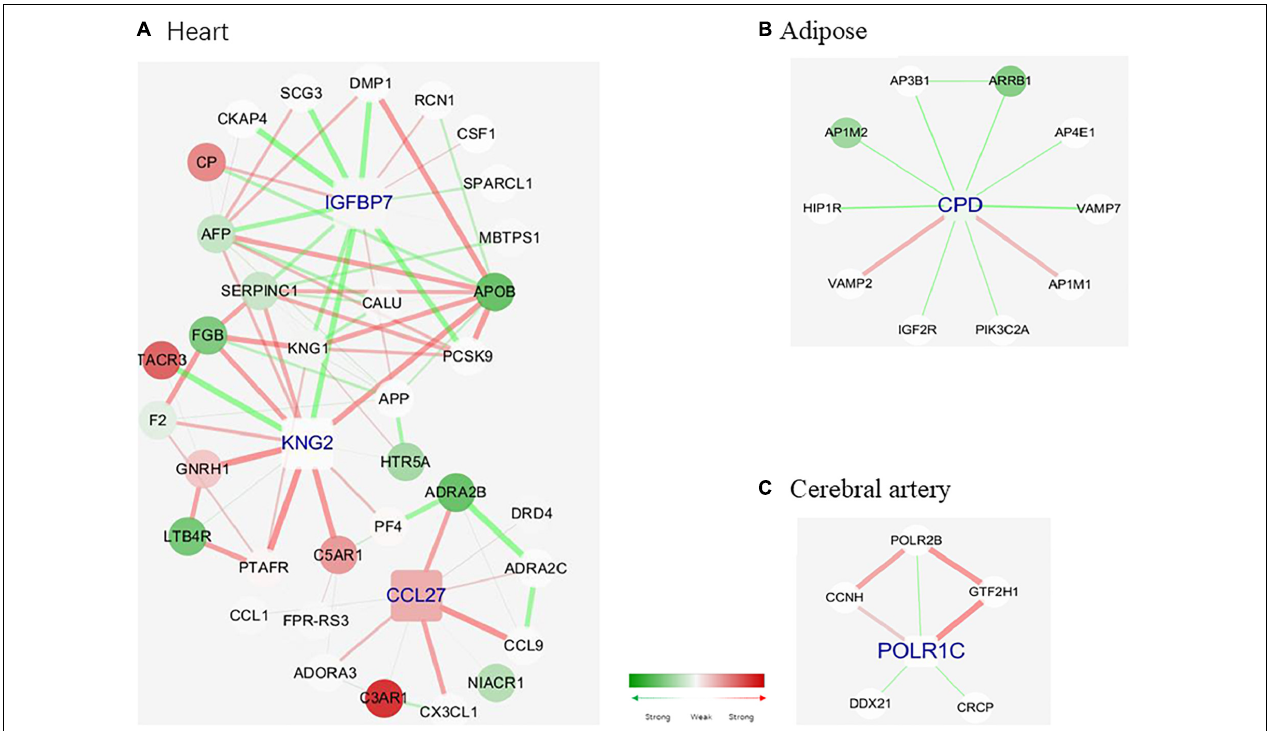
FIGURE 6 | Tissue-specific hub genes and their corresponding modules. (A) IGFBP 7, KNG 2, and CCL 27. (B) CPD. (C) POLR1C. Gene colored in green means differential expression between disease and health conditions and was significantly downregulated under disease, while red means upregulated. One edge colored with green means the interaction between its two linked genes was perturbed and was inactivated under disease condition, while red means activated. The width of edges reflects the magnitude of the perturbation. Tissue-specific hub genes were shaped with round rectangle and labeled with